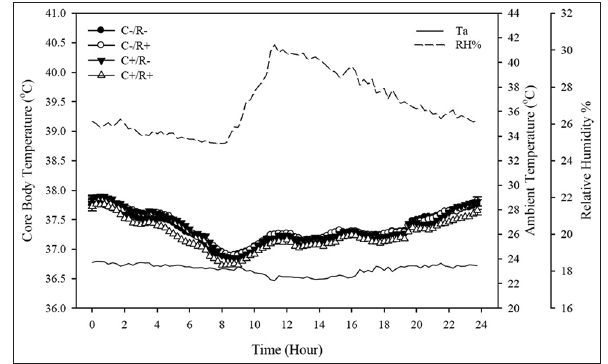
Figure-2: Daily mean (±SE) core body temperature of rats while under thermoneutral conditions. Thermoneutrality (ambient temperature; T =23.15±0.04°C) was maintained a between days 0 and 28. Then, heat stress (HS) was imposed in two subsequent phases; an acute HS wave (T =35.86±0.37°C; 00:00-09:00 h) on day 29 of the trial, a followed immediately by chronic HS (T =32.28±1.00°C); a until the end of the trial (day 34). The treatments were hypercholesterolemia-inducing (HC) diet (C+) and/or resveratrol (R+): C-/R- (control) group fed a control diet throughout the trial. The C+/R- group consumed the HC diet (containing 1% purified cholesterol along with 0.5% cholic acid, with high-fat-based mixture), throughout the trial. The C-/R+ was fed the control diet and received a dose of 13 mg/kg BW/day of purified trans-resveratrol by oral gavage during the past 5 days of the trial. The C+/R+ group consumed the HC diet and received the R+ treatment as explained. No treatment by time interaction was found